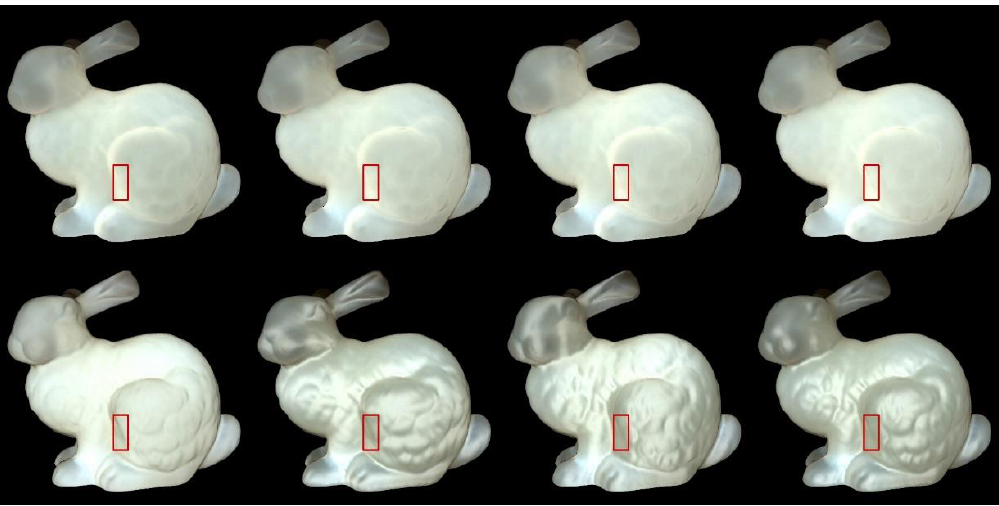
Figure 7. Comparison of highlight effects generated by our Ashikhmin-based method (first row) and the method based on the traditional Ashikhmin model (second row) for chocolate milk (regular) material. From left to right, the n t , n b parameters are n t is 2, n b is 2; n t is 2, n b is 10; n t is 10, n b is 2; n t is 10, n b is 10.